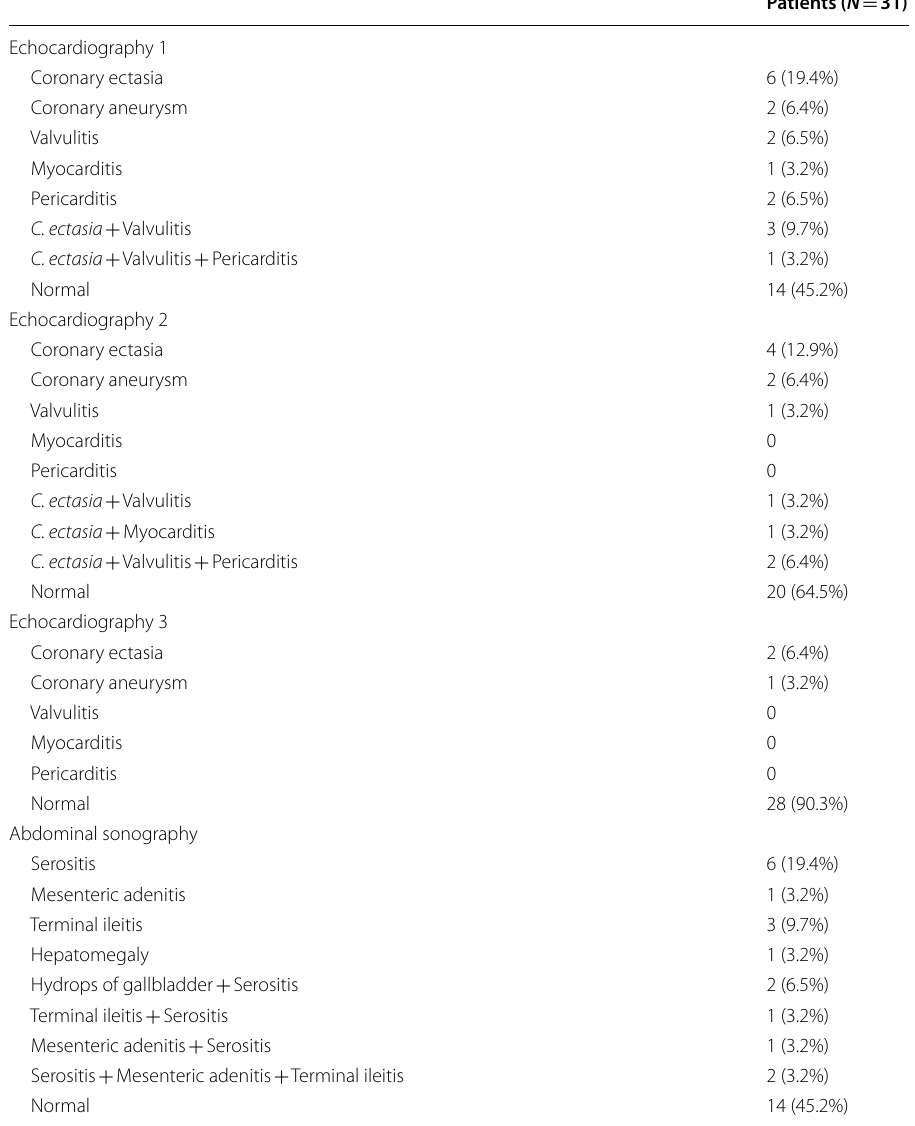
Table 4 The echocardiography and abdominal sonography findings of pediatric patients with hyper-inflammatory features after